Question: Write a descriptive caption for this figure.
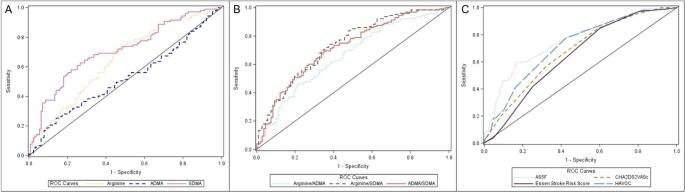
Answer: ROC-analysis for distinguishing between CES and ESUS with ( A ) biomarker levels, ( B ) biomarker ratios and ( C ) AF-scores